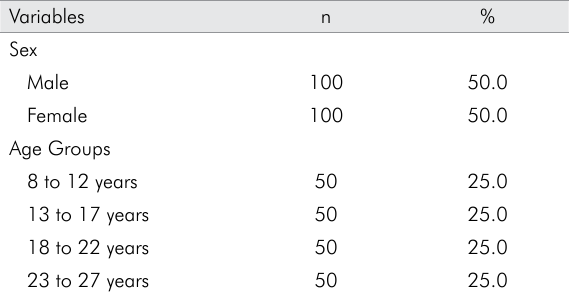
Table 2. Description of the evaluators.